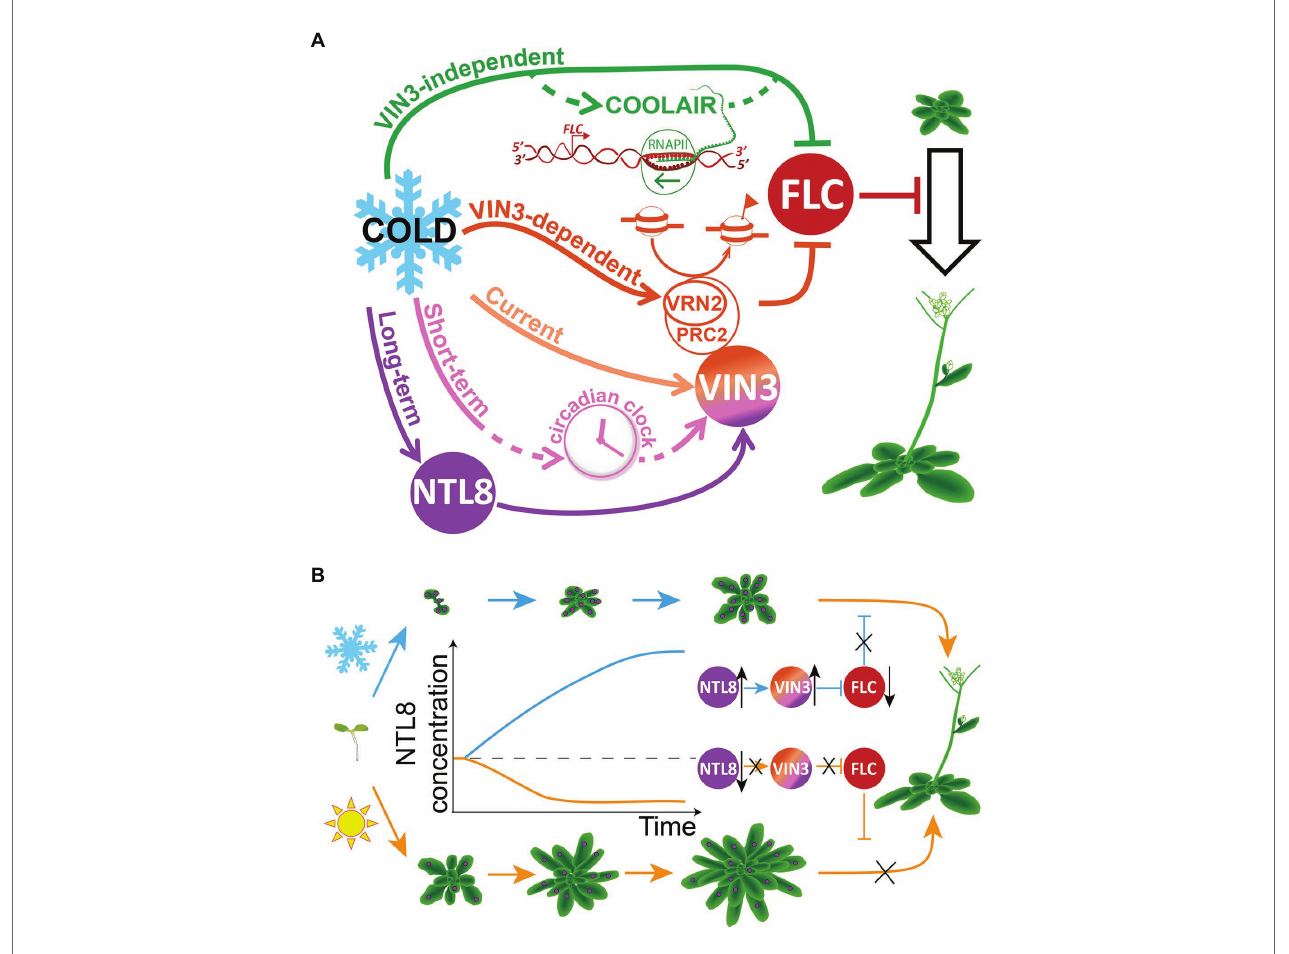
FIGURE 2 | Distributed temperature sensitivities in the regulation of FLOWERING LOCUS C ( FLC ) and VERNALIZATION INSENSITIVE3 ( VIN3 ), and indirect long-term temperature sensing through NTL8 during vernalization. (A) Temperature sensitivities are widely distributed in the regulation of VIN3 and FLC during vernalization. Cold regulates VIN3 and FLC through multiple pathways: at least five separate pathways have been shown to be needed. In some cases, such as the “Long-term” pathway, the mechanism and components are known (NTL8; Zhao et al., 2020b). Known and postulated components are illustrated schematically in the diagram. (B) Temperature-dependent growth is indirectly exploited by the NTL8 protein to sense long-term cold. NTL8 concentration decreases when the plant grows fast in the warm (bottom, orange arrows/curves), but slowly increases when the plant grows slowly in the cold (top, blue arrows/curves). The slow accumulation of NTL8 protein holds the memory of cold exposure in the cold, allowing a slow increase in VIN3 concentration, which promotes the epigenetic repression of FLC – a repressor of the floral transition. Purple circles on the plant indicate NTL8 protein. The total amount of protein shown is the same in warm and cold, but the concentration is different due to the difference in growth